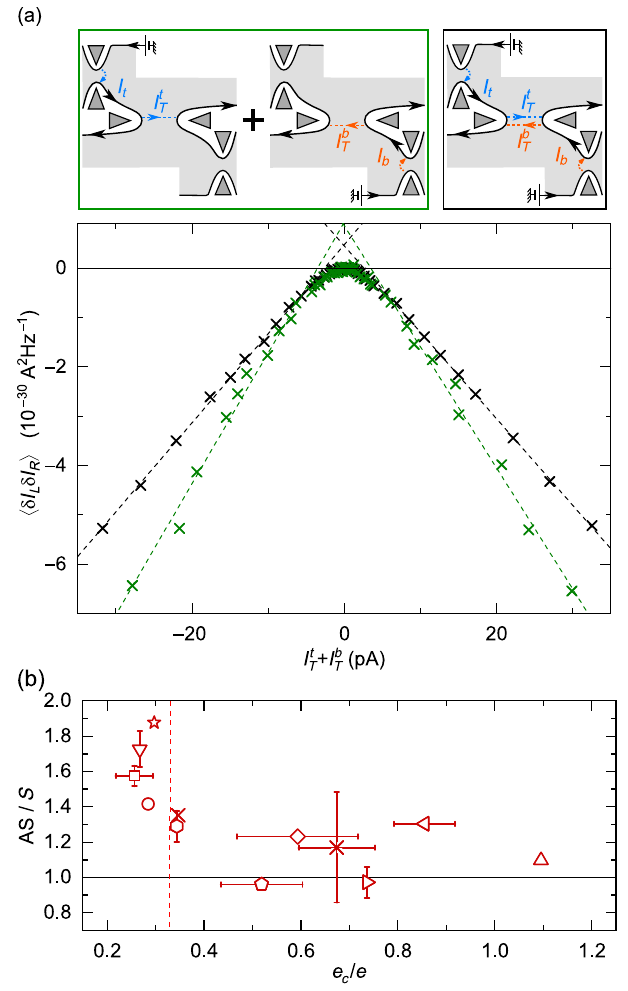
FIG. 4. Discriminating anyons braiding from Andreev mecha- ≈ e ≈ e= 3 . nisms. (a) Cross-correlations with QPC set to e c c t;b The data (symbols, corresponding to those in Fig. 3) are displayed as a function of the sum I t of tunneling currents from the top þ I b T T and bottom sources (see the inset; arrows indicate the sign þ convention). Black crosses are obtained with two symmetric ≈ I incident beams I . Green crosses show the sum of indepen- t b δ I δ I δ I I I dent measurements h δ I , using either L R ið t Þ þ h L R ið b Þ QPC or QPC as a single source, versus I t ð I t Þ þ I b ð I b Þ . Dashed t b T T linesare linear fits.The significantlylargerslope inthe asymmetric case (green) rules out Andreev processes and is consistent with the predicted anyon exchange mechanism. (b) Symbols represent the δ I = ð I t ratio (AS/S) of the slopes h δ I þ I b Þ between asymmet- L R i T T ric [one source at a time (AS)] and symmetric [two sources (S)] =e . incident quasiparticle beams versus separately characterized e c Error bars encompass the difference between values extracted at negative and positive applied voltages for the same device setting. ≳ 0 . 5 > e ≈ e= 3 , where the A ratio close to unity is found for e c t;b charge mismatch favors Andreev